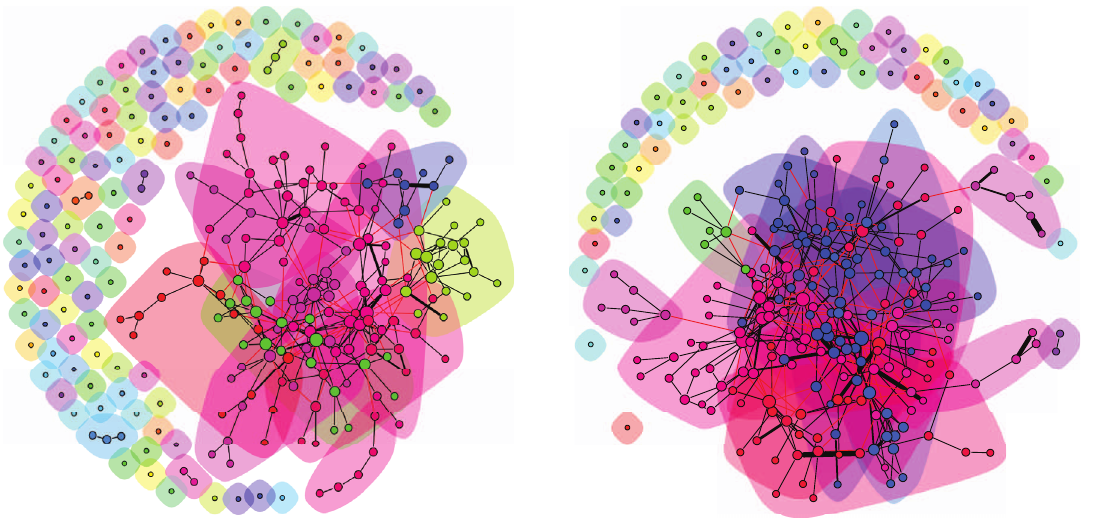
Figure 7. Communities in the subgraph of firms projection in 2005 (Left) and 2010 (Right) considering transnational links only. The size of a node is proportional to the square root of its number of connections, the thickness of an edge is proportional to the number of shared directors between the connecting boards. Colors refer to the best-found community partition, whose weighted modularity score is 0 : 6595 for 2005 and 0 : 6508 for 2010. Note that the largest connected component covers 58 : 87% of the transnational subgraph in 2005, and 77 : 99% in